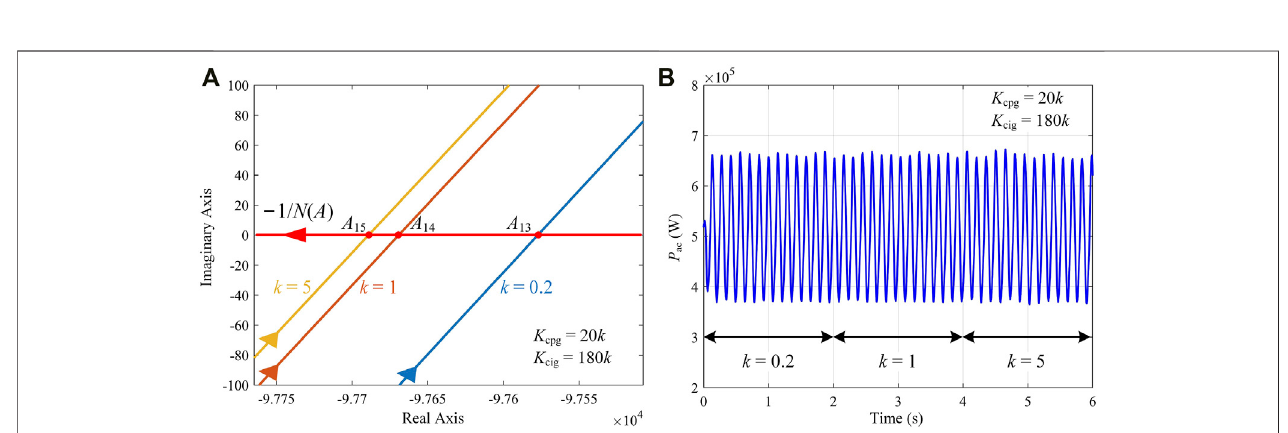
FIGURE 9 | Stability analyses and simulations when changing GSC current-loop parameters K cpg and K cig . (A) Stability analyses based on the DF method. (B) Power output.